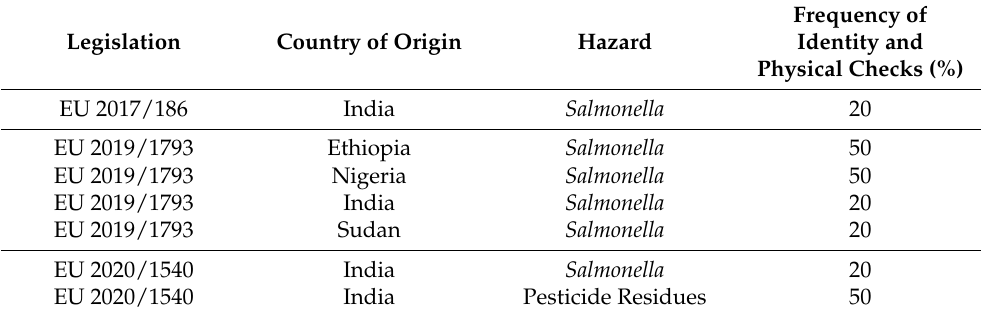
Table 2. Official controls sampling frequency for sesame seeds (2017–2020) (Source: Adapted from